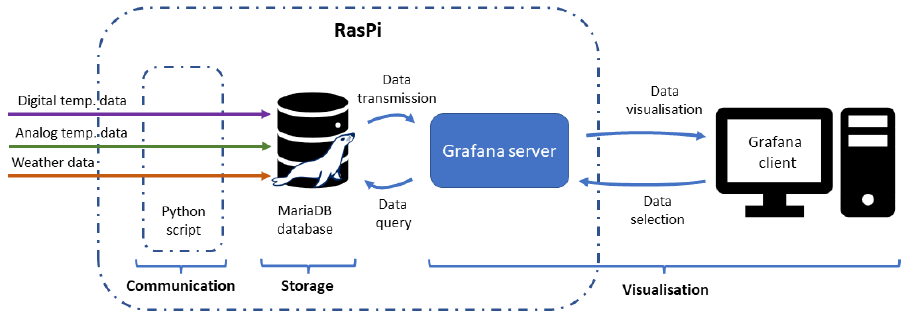
Figure 2. Data storage and visualisation processes carried out by the RasPi.